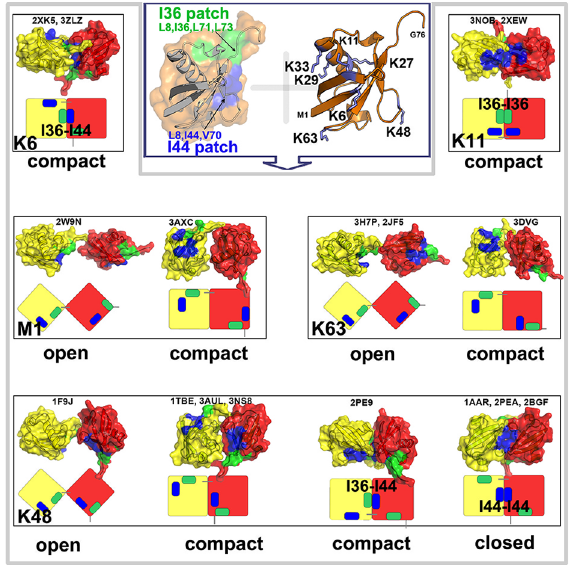
Figure 1. Experimental structures of diUbs with different linkages. Only five linkage types have been structurally characterized (summarized in Table 1 in Text S1). The corresponding structures are shown with the distal Ub unit (contributes a carboxyl group of G76 to form the linkage) in yellow and the proximal Ub unit (contributes an E - amino group of lysine) in red, above a schematic cartoon. The formation of Ub interfaces is mainly contributed by two hydrophobic patches. One is the I44 patch (color in blue) consisting of L8, I44, V70, another is the I36 patch (colored in green) involving L8, I36, L71 and L73. These experimental structures include: compact structure of K6-linked diUb (2XK5, 3ZLZ), compact structure of K11-linked diUb (3NOB, 2XEW), open and compact structures of M1-linked diUb (2W9N, 3AXC, respectively), open and compact structures of K63-linked diUb (2JF5 and 3H7P, 3DVG, respectively), and four distinct structures of K48-diUb consisting of open (1F9J), closed (1AAR) and two compact conformations (1TBE, 3AUL, 3NS8 and 2PE9, respectively).